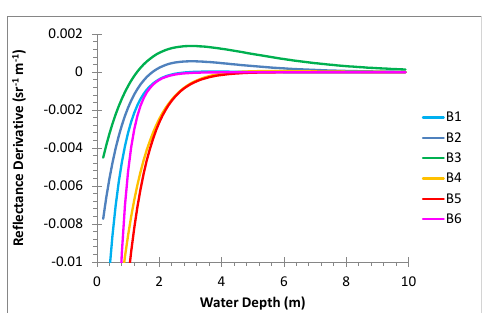
Figure 5. Derivative of reflectance with respect to water depth for the first 6 spectral bands of WorldView-2 for coastal sea water with a bright sandy seabed. Figure 2. A typical reflectance spectrum of coastal sea water with a bright sandy bottom and 2 m water depth. The solid blue line is the computed spectrum while the red dots are the in-band effective reflectance of WorldView-2 plotted at their respective effective wavelengths.